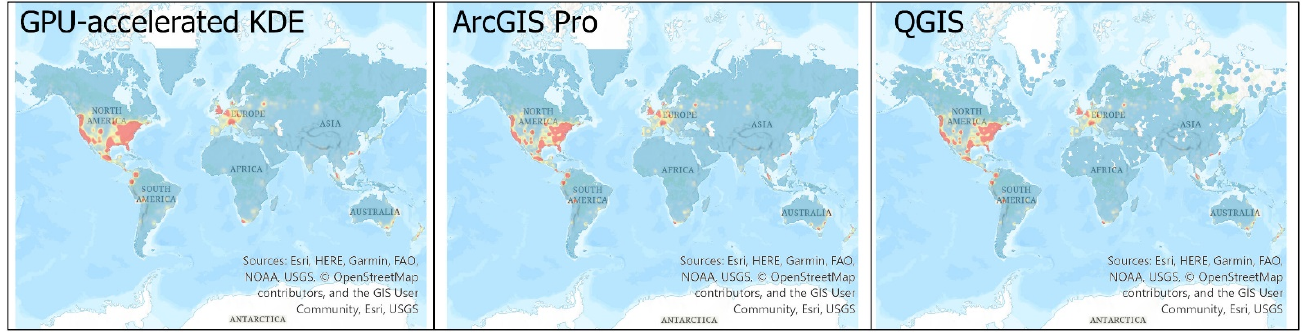
Figure 5. Density surfaces (5 km resolution) estimated using the GPU-parallel KDE tool (Gaussian kernel; default bandwidth = 134,330 m), and using the KDE tools in ArcGIS Pro (Quartic kernel; default bandwidth = 250,891 m) and in QGIS (Quartic kernel, bandwidth = 250,891 m). Table 2. Execution time of the KDE tools to estimate density surfaces at varied spatial resolutions using the 2019 iNaturalist data ( n = 11,986,484 points) with a fixed bandwidth. Higher spatial reso- lution represents KDE task involving larger datasets. The KDE tool in Pro were run with both one thread and eight threads. Experiments were conducted on the server computer running Windows Server 2016 with a NVIDIA Tesla GPU.